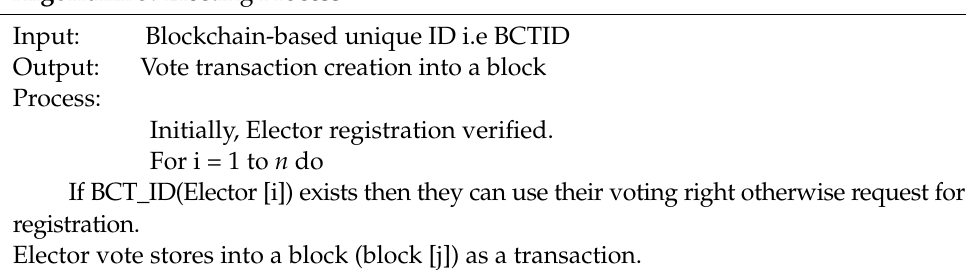
Table 2. System operations with gas cost.